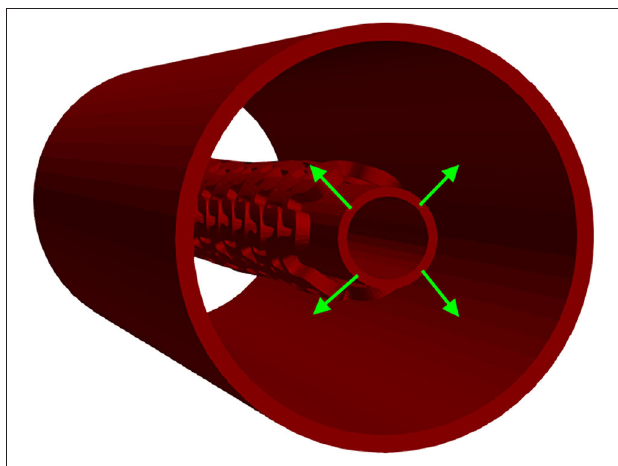
FIGURE 6 | Inflation test. Stent configuration at the end of a radial compression test is taken as input for the inflation test. The stent is then inflated using prescribed pressures applied at the outer surfaces of the inner